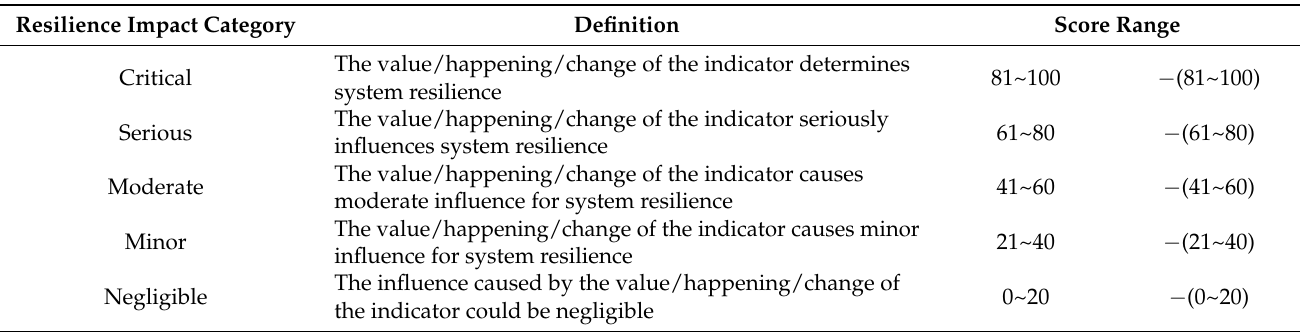
Table 2. Resilience impact score.